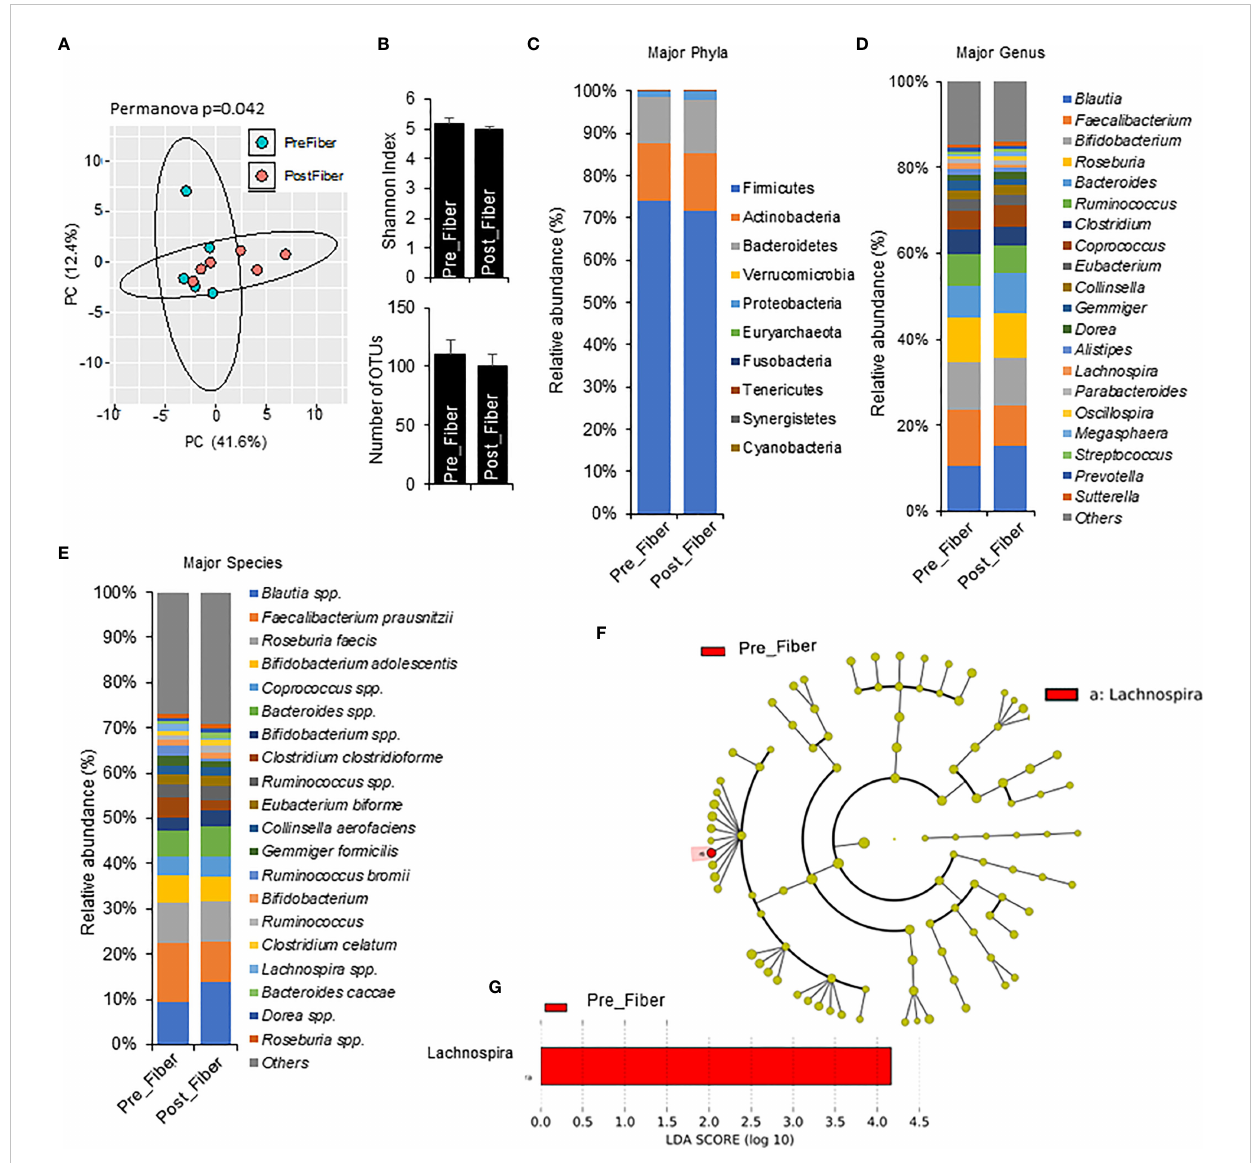
FIGURE 4 Microbiome signatures in pre metformin/prebiotic and Phase 1 metformin/prebiotic. (A) Principal component analysis of beta-diversity shows that microbiota composition differed between Pre_Fiber (pre Phase 1 metformin/prebiotic) and Post_Fiber (phase 1 metformin/prebiotic). (B) The alpha- diversity measure, Shannon Index and number of OTUs did not differ between groups. (C – E) The abundance of major phyla, genus, and species show marginal differences between Pre_Fiber and Post_Fiber. (F, G) LEfSe (Linear discriminant analysis Effect Size) analysis showed unique biomarkers in Pre_Fiber vs Post_Fiber. Data are mean and standard error of mean. Microbiome beta-diversity was assessed using the Bray-Curtis dissimilarity index and visualized with principal component analysis. The alpha-diversity indices and bacterial proportions were compared using the Kruskal-Wallis test followed by the Mann-Whitney multiple pairwise comparison